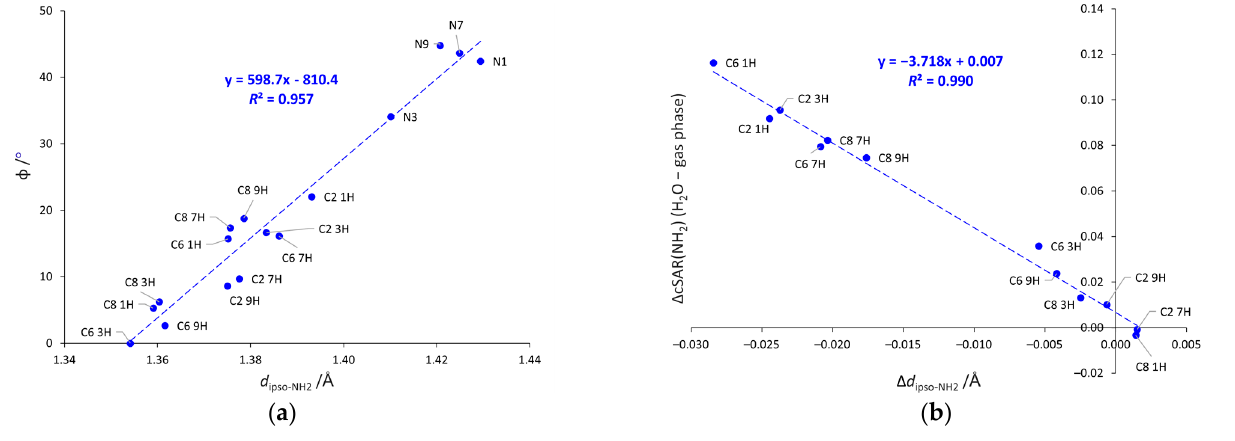
Figure 4. Dependences between ( a ) the pyramidalization, angle φ , and d ipso-NH2 , and ( b ) differences, Δ , in cSAR(NH 2 ) and d ipso-NH2 values calculated in water and in the gas phase ( Δ = 0 means that the same values of a given parameter were obtained in water and in gas phase). N-NH 2 systems not included in ( b ).